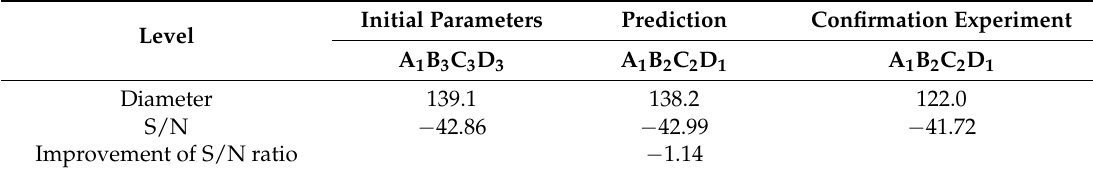
Table 7. Confirmation experiment.